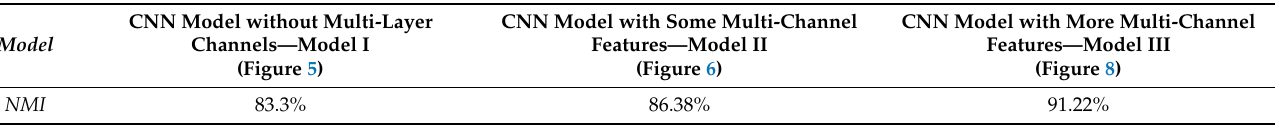
Table 1. The effect of adding specific features on NMI Scores. The values obtained for the input features for the various deep-learning models used (for the test datasets used in this work).